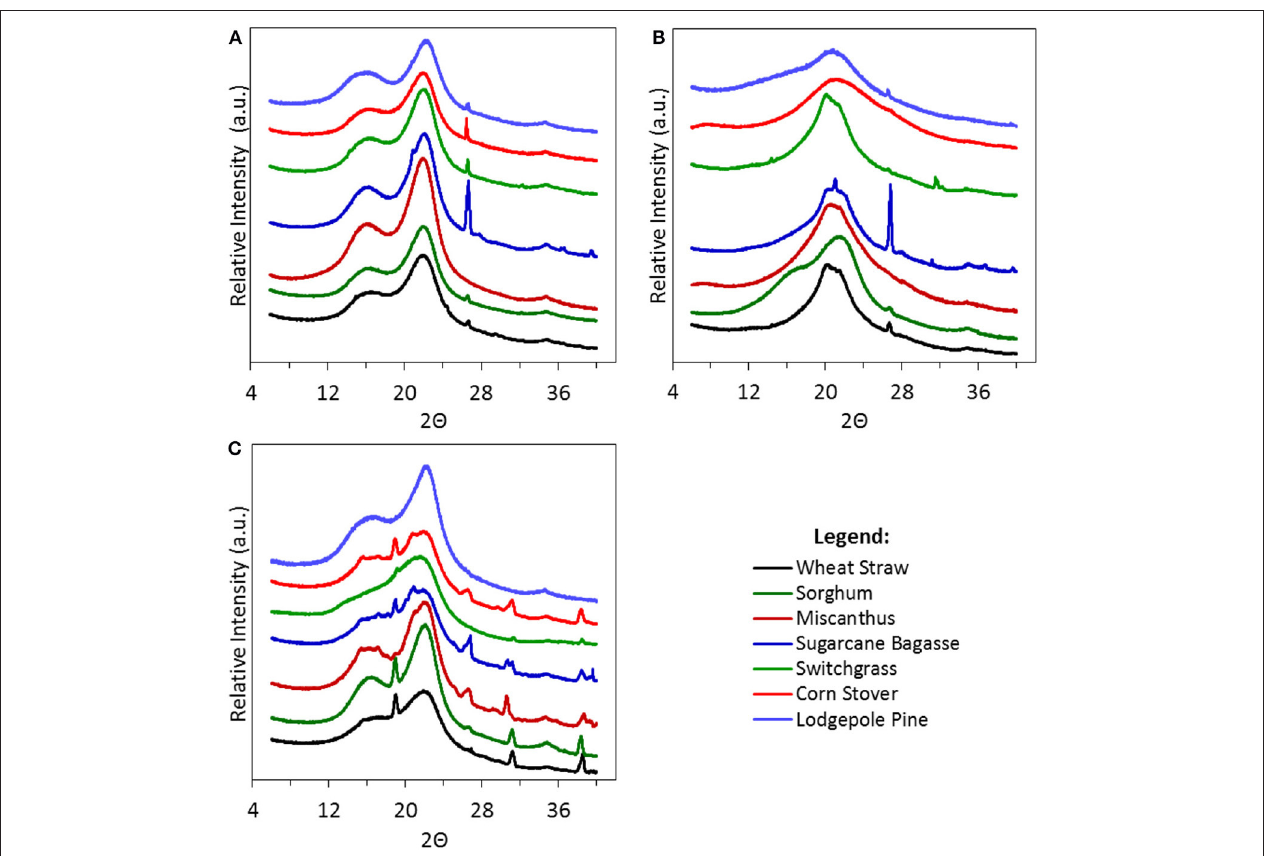
FIGURE 5 | XRD of several biomass types before reaction (A) and after reaction with Emim Ac (B) or Bmim PF 6 (C) .